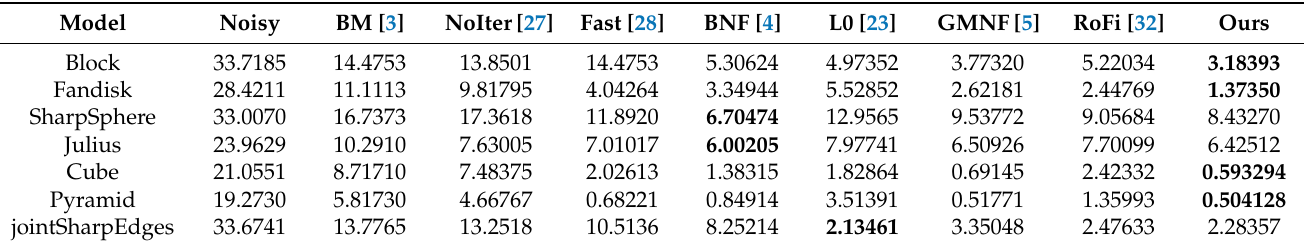
Table 2. The average normal difference N mean (in degrees) between the facet normals of the denoised mesh and the ground-truth facet normals. The lowest value per row is highlighted in bold.